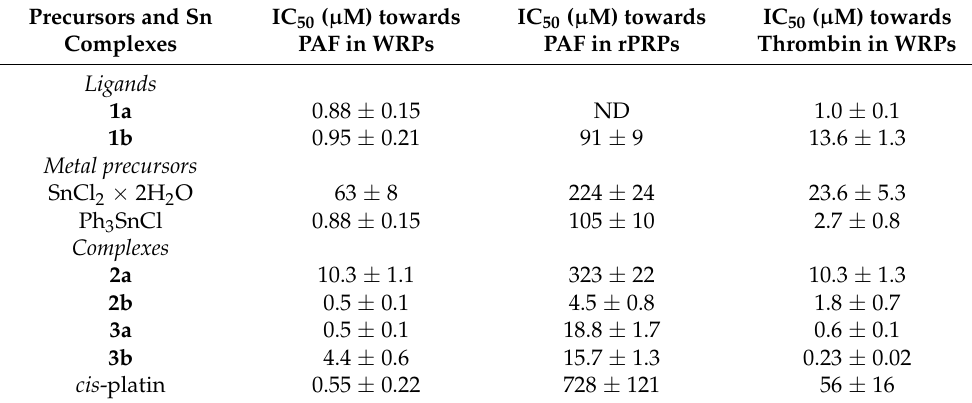
Table 1. Inhibition of PAF- and thrombin-induced aggregation by tin(II) and tin(IV) organometallic compounds complexes, ligands and metal precursors towards WRPs and rPRPs. ND = not